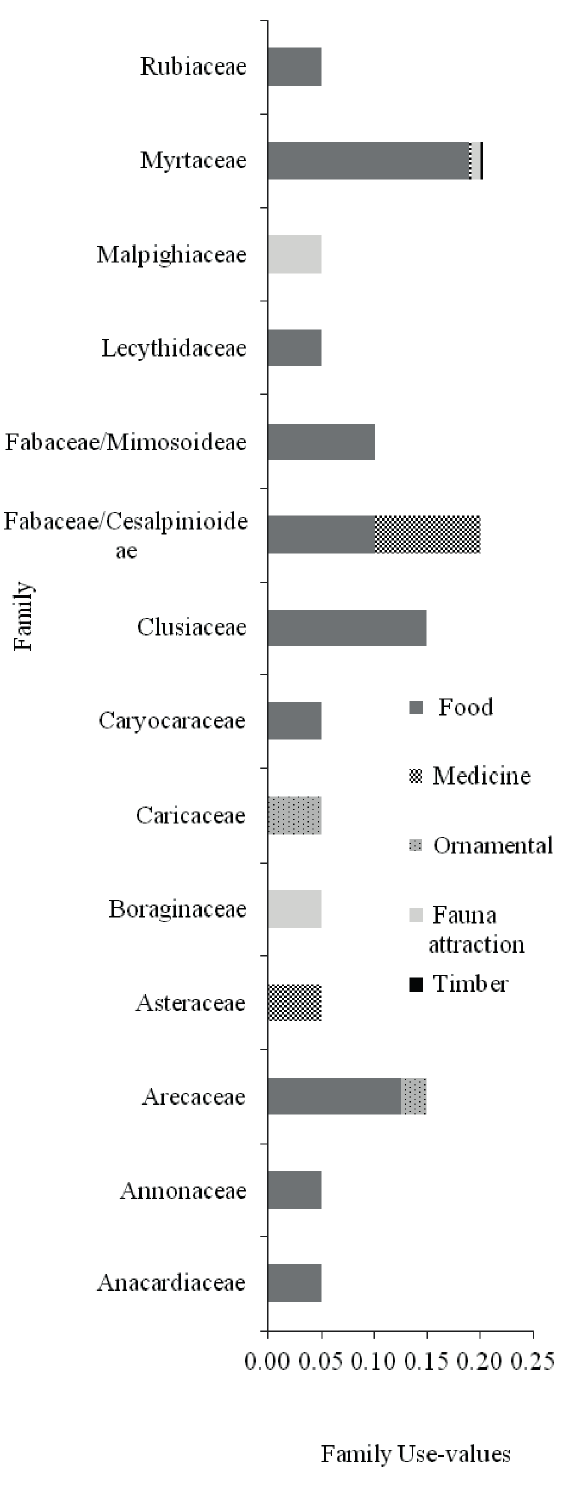
Figure 1 - The Family Use-values and use categories of native arboreal species employed by rural by dwellers of the mountain region of Espírito Santo,